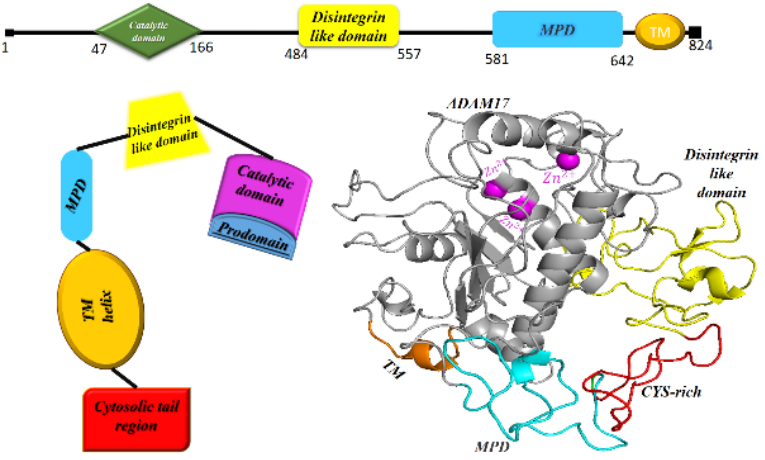
Figure 5. Linear representation of distinct domains, schematic and three dimensional shape of ADAM17 (PDB ID: 2DDF [164], PyMol molecular graphics system). Cys ‐ rich: cysteine rich domain; MPD: membrane proximal domain; TMD: transmembrane domain.